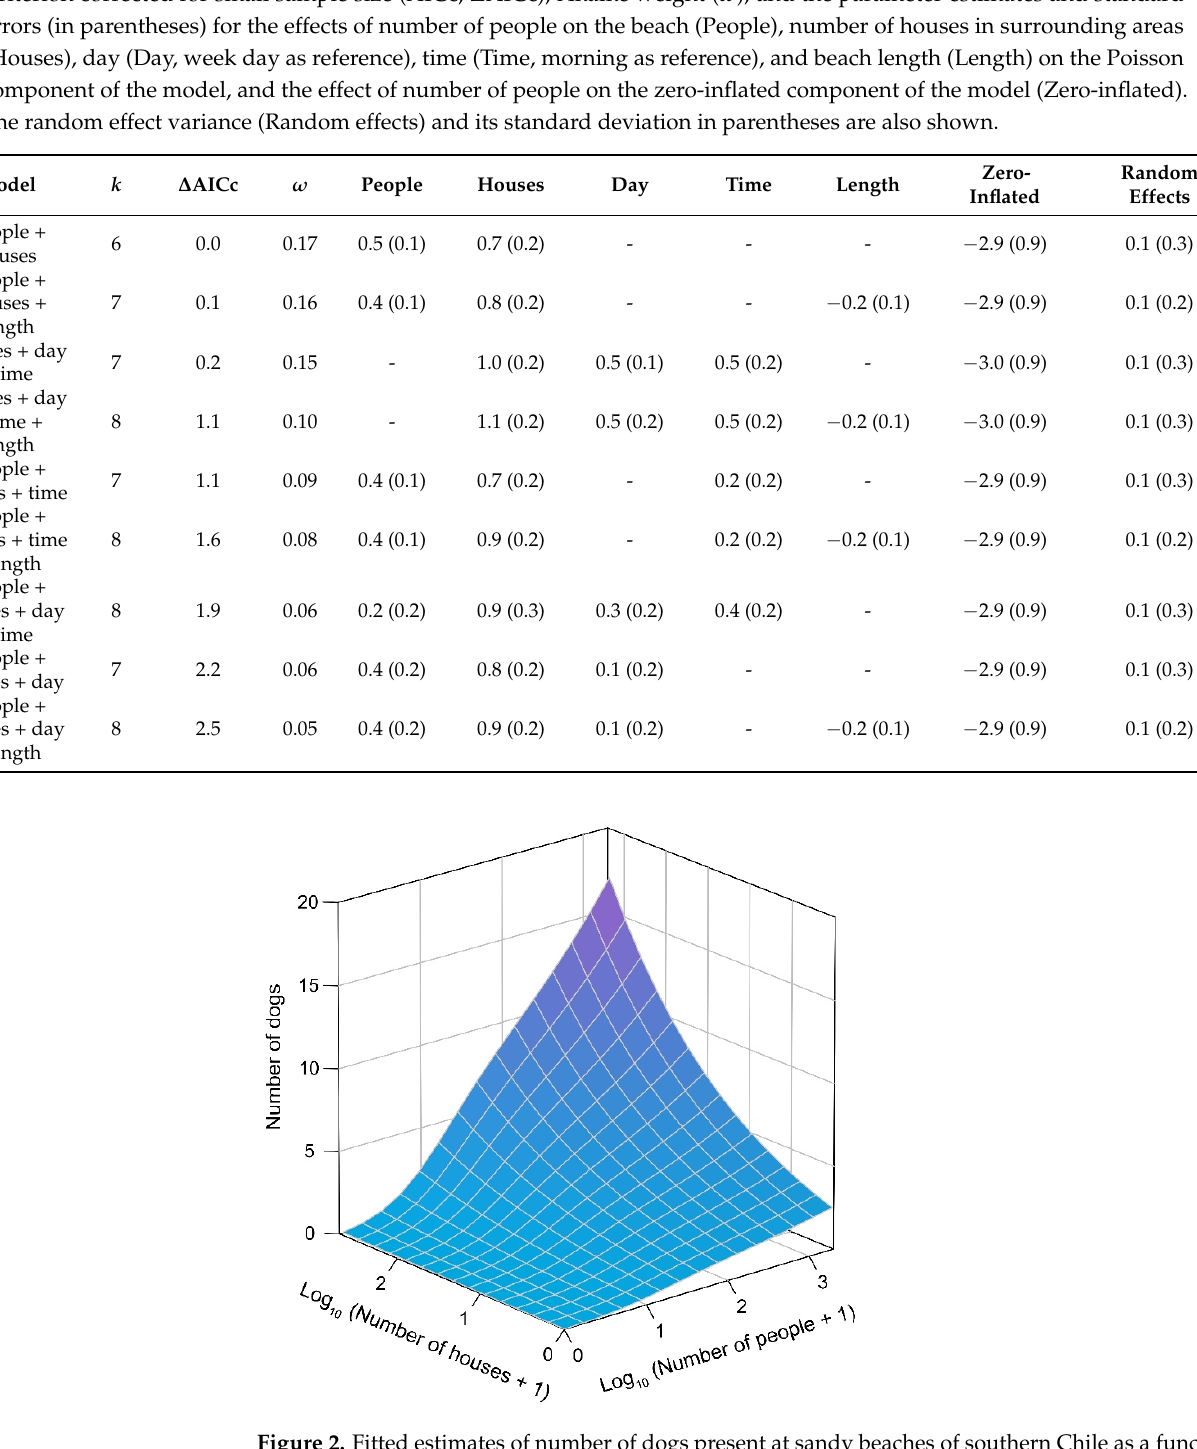
Figure 2. Fitted estimates of number of dogs present at sandy beaches of southern Chile as a function of the number of houses (roofs counted within a 200 m buffer) and number of people present on the beach at the moment of sampling. Note that number of people and number of houses were log-transformed.